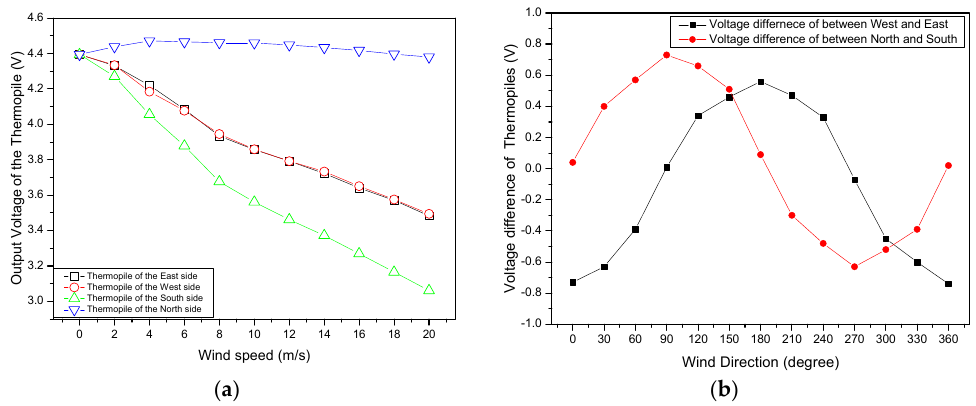
Figure 5. Measured output voltages of thermopiles depending on wind speed and wind direction. ( a ) The output voltage with wind speed (the wind direction is from south to north); ( b ) Voltage difference for west-east and north-south with wind direction (the wind direction at zero degrees is from north to south).